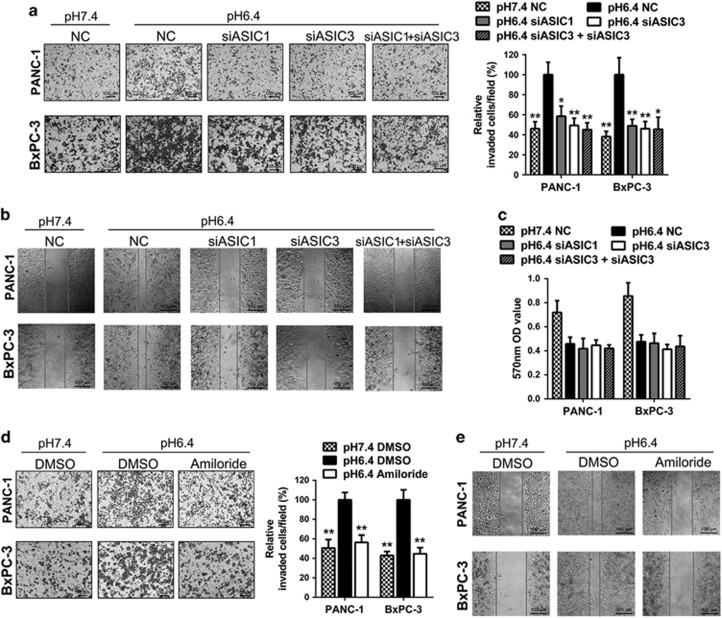
Inhibition of ASIC1 and ASIC3 suppresses acidity-promoted invasion and migration of pancreatic cancer cells. PANC-1 and BxPC-3 were transfected with negative control (NC) or siRNA of ASIC1 and ASIC3 (siASIC1 and siASIC3) and cultured in pH 7.4 or pH 6.4 medium as indicated for 48 h. (a) The invasive ability was evaluated by Transwell assay. The histogram showed the percentage of invasion cells per field when compared with negative control cultured in pH 6.4 medium. (b) The migration ability was measured by wound-healing assay. (c) The cell viability was measured by MTT assay. PANC-1 and BxPC-3 were treated with amiloride and DMSO, and cultured in pH 7.4 or pH 6.4 medium as indicated for 48 h. (d) The invasive ability was evaluated by Transwell assay. The histogram showed the percentage of invasion cells per field when compared with negative control cultured in pH 6.4 medium. (e) The migration ability was measured by wound-healing assay. Experiments were performed three times in triplicate and were presented as means±S.D. (*P<0.05; **P<0.01)